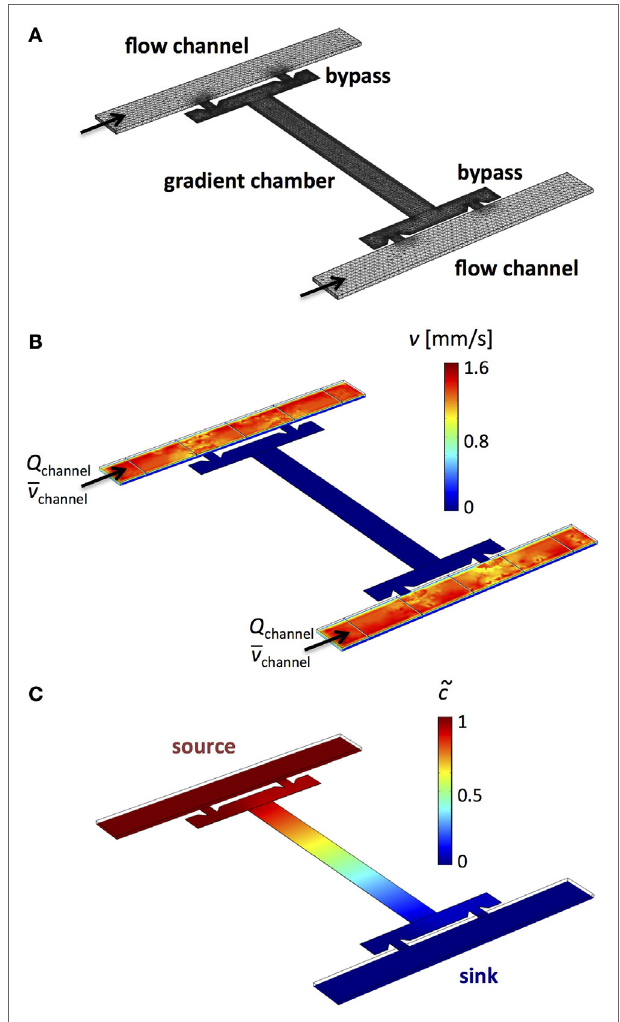
FigUre 1 | Microfluidic device design for flow-free and steady-state linear gradients . (a) Design of a multi-height device with two flow channels, corresponding bypasses, and a rectangular microchamber. (B) Computational simulation of the flow velocity distribution within the microfluidic device reveals advective transport in the two flow channels and absence of flow across the rectangular microchamber. (c) A linear concentration gradient across the rectangular microchamber is generated when one flow channel acts as the concentration source and the other flow channel as the